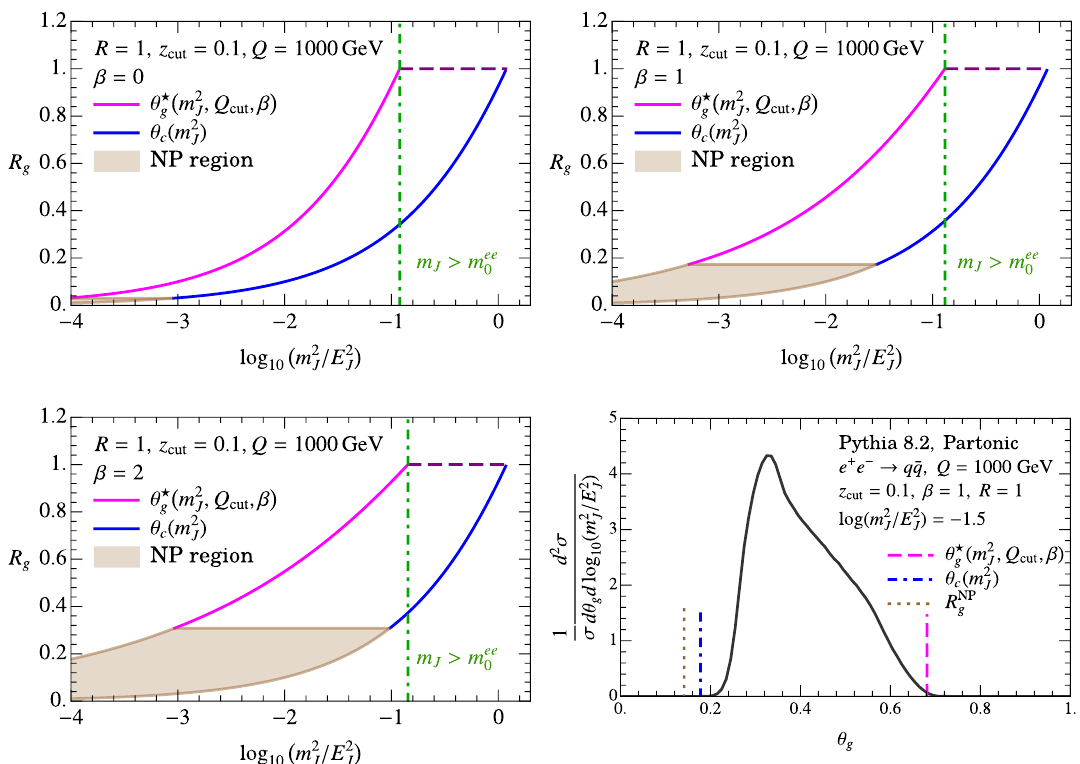
Figure 1 . Kinematic constraints on the range of R g for β = 0 , 1 , 2 with Q = 1000 GeV and z cut = 0 . 1 . The R g is constrained between θ c ( m 2 green line corresponds to the groomed to ungroomed transition. The shaded brown region demar- cates the phase space where hadronization corrections are critical. In the bottom-right panel we show the distribution of the double differential distribution from Pythia for representative values of z cut = 0 . 1 , β = 1 and log boundaries and a rough estimate of the angle R NP